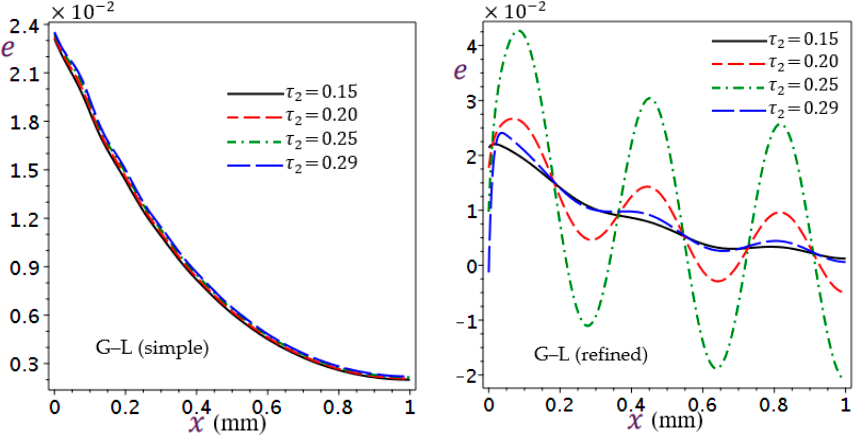
Figure 16. Effect of second relaxation time τ 2 of G–L theory on dilatation e .